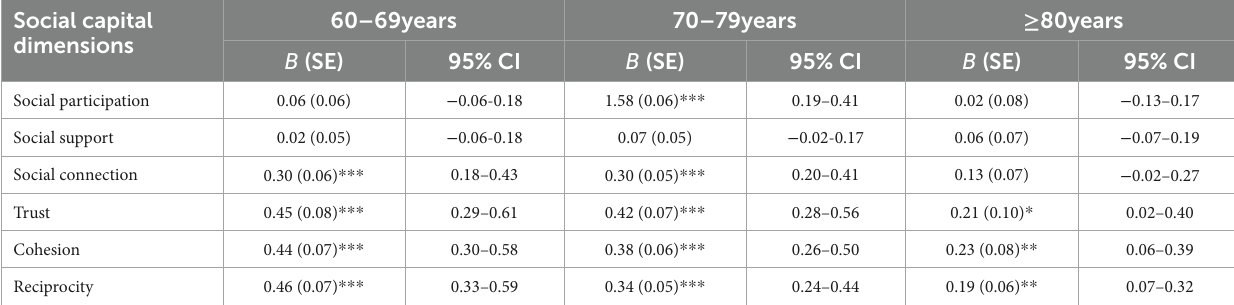
TABLE 4 The relationship between social capital and eHealth literacy among different age